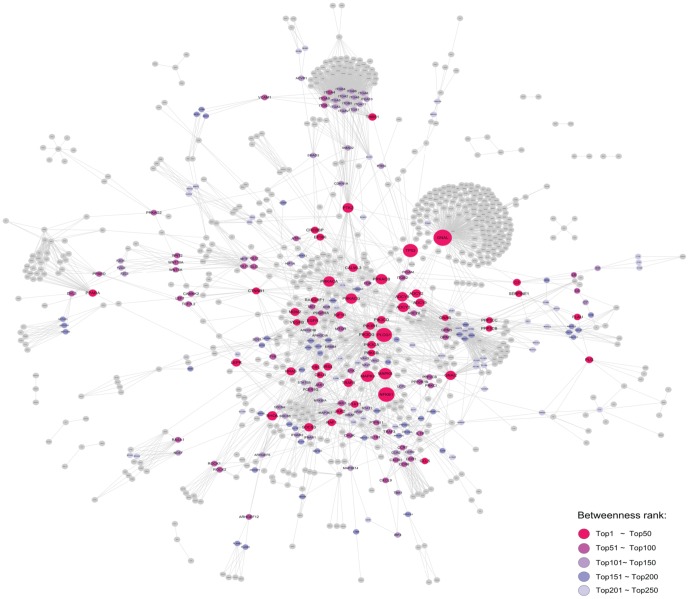
Biological network of mutated genes from significantly mutated pathways.The node size increases are proportionate to the increases in the betweenness coefficient.